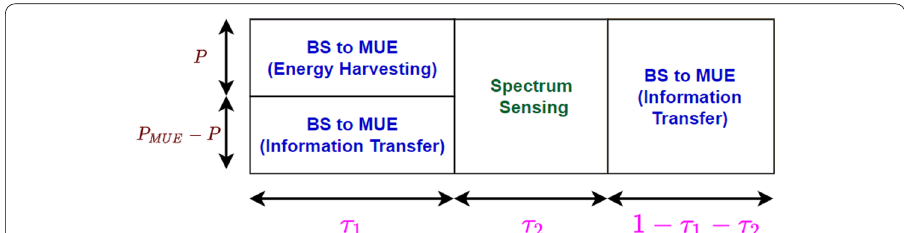
Fig. 2 Time slot structure of bidirectional CR